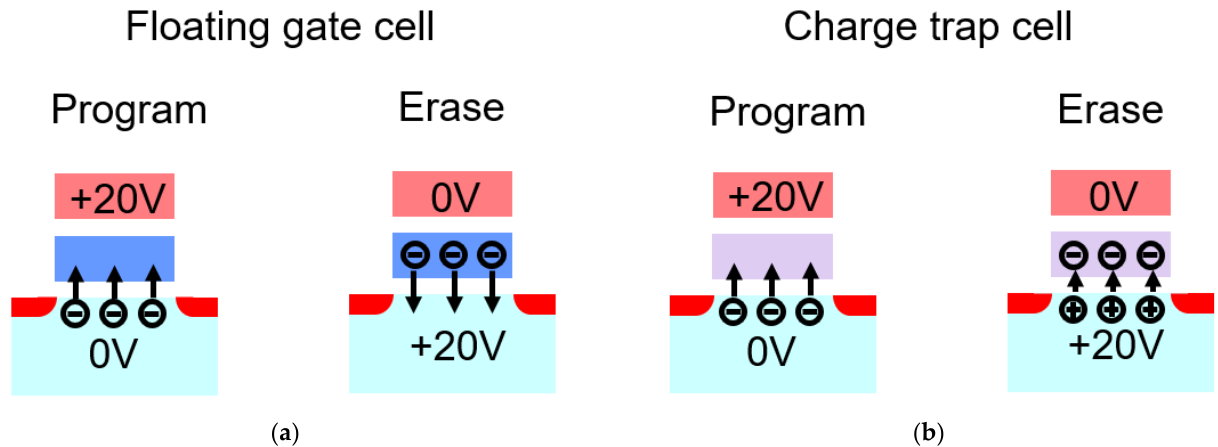
Figure 6. Program and erase operations for ( a ) floating gate cell and ( b ) charge-trap cell. In the charge-trap cell, holes are injected to the storage layer by direct tunneling.